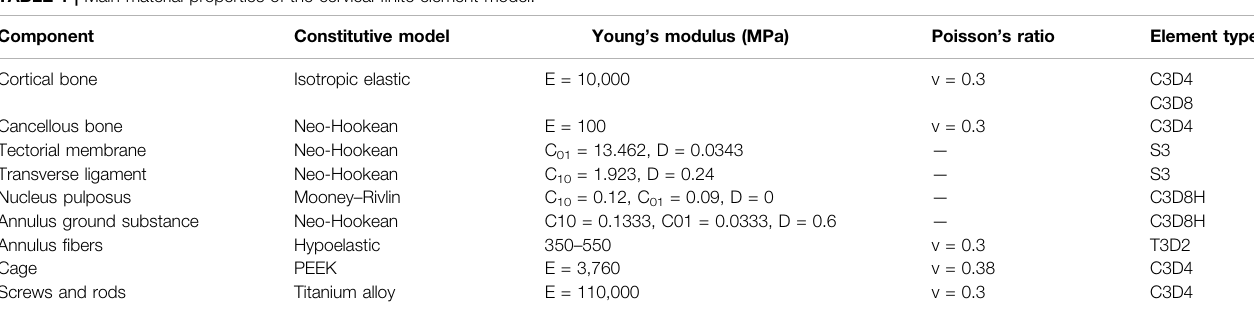
TABLE 1 | Main material properties of the cervical fi nite element model.